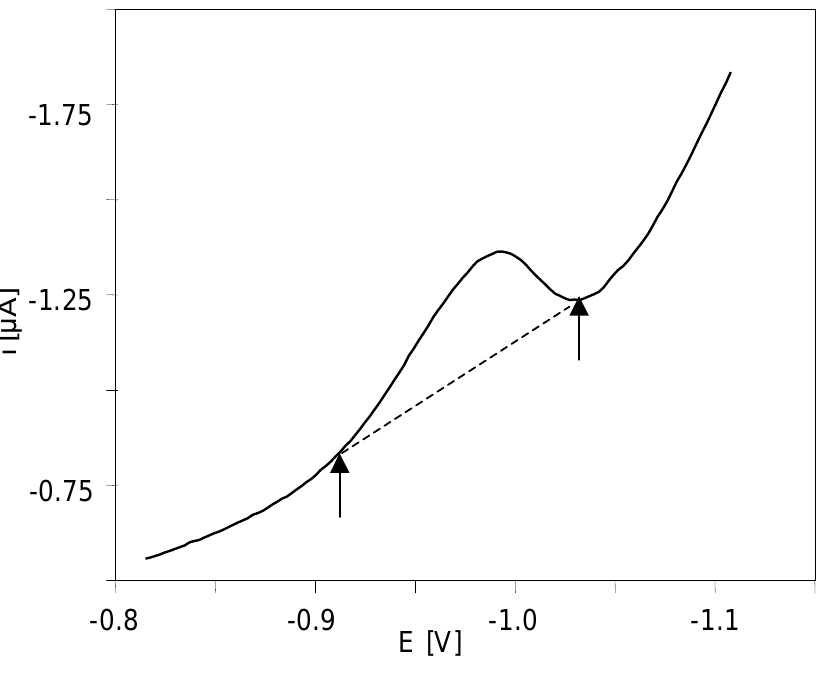
Figure 2. Cyclic voltammetry reductive desorption of 3,3’-dithiodipropionic acid di(N-succinimidyl ester) from gold piezoelectrode after two hours of modification in 5 mM of chloroform solution. Measurement conditions: 0.5 M KOH, potential scan rate 100